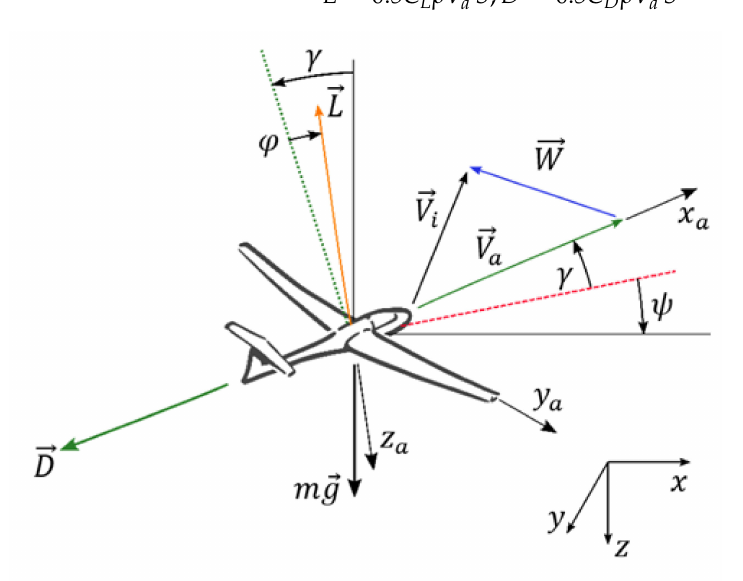
Figure 3. Conventions for forces, angles, and